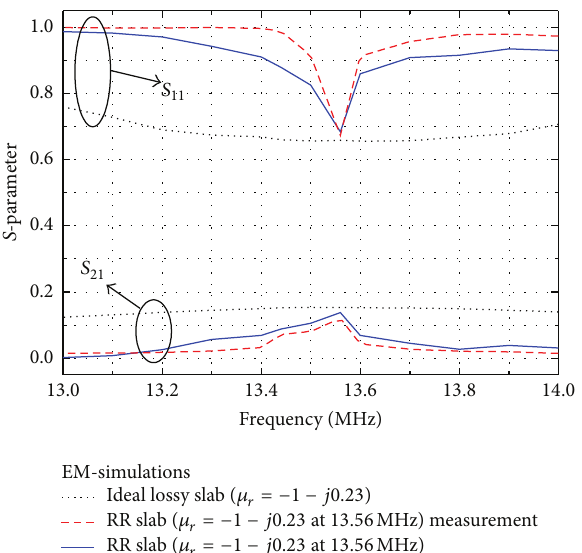
Figure 6: Comparison of 𝑆 -parameters for the cases of using lossy = 5.5 cm, 𝑟 = 0.1cm, 𝑅 𝐿 = 50 Ω , 𝑑 = 24 cm, 𝑎 = 𝑏 = 6cm, slabs ( 𝑟 loop ring 𝑠 = 12cm, and ℎ = 36cm).